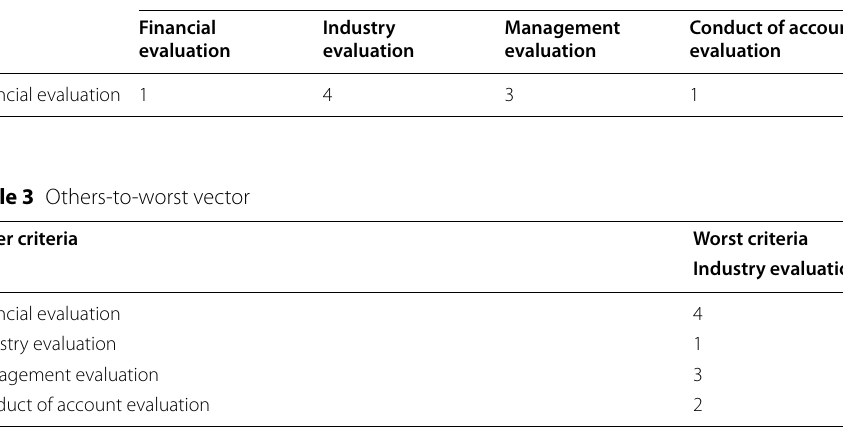
Table 2 Best-to-others vector under the main criteria Best criteria